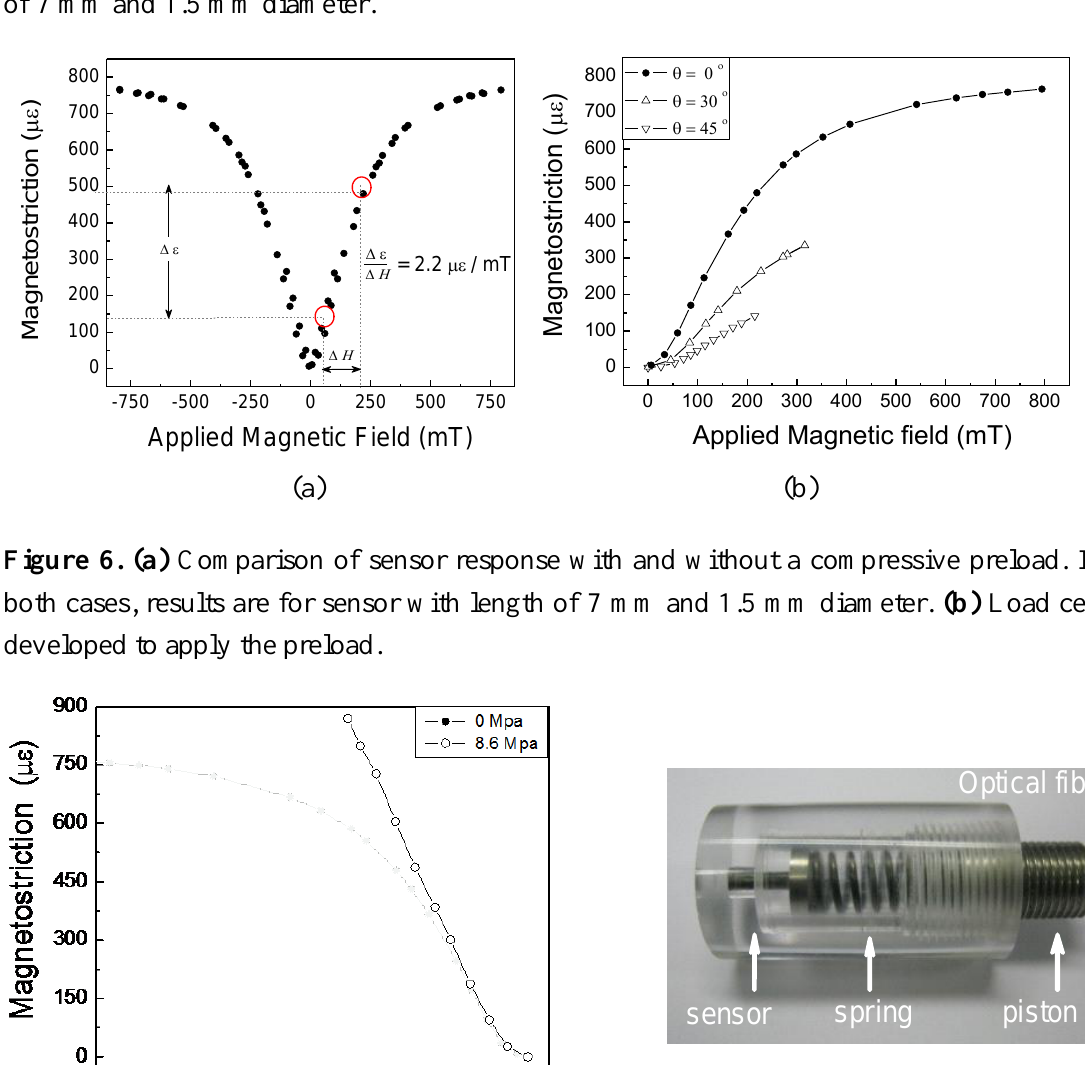
Figure 5. (a) Sensor response without a preload; (b) Sensor sensibility changes with the angle between sensor axis and the applied magnetic field. Results are for sensor with length of 7 mm and 1.5 mm diameter.